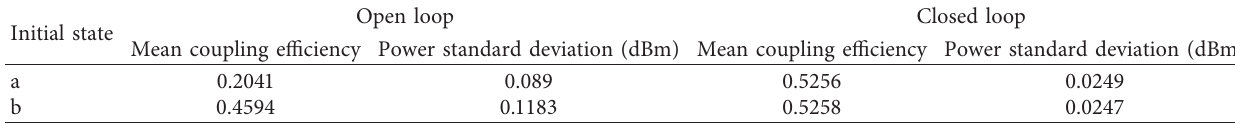
Table 2: Comparison of the open- and closed-loop system results under different initial conditions. Initial